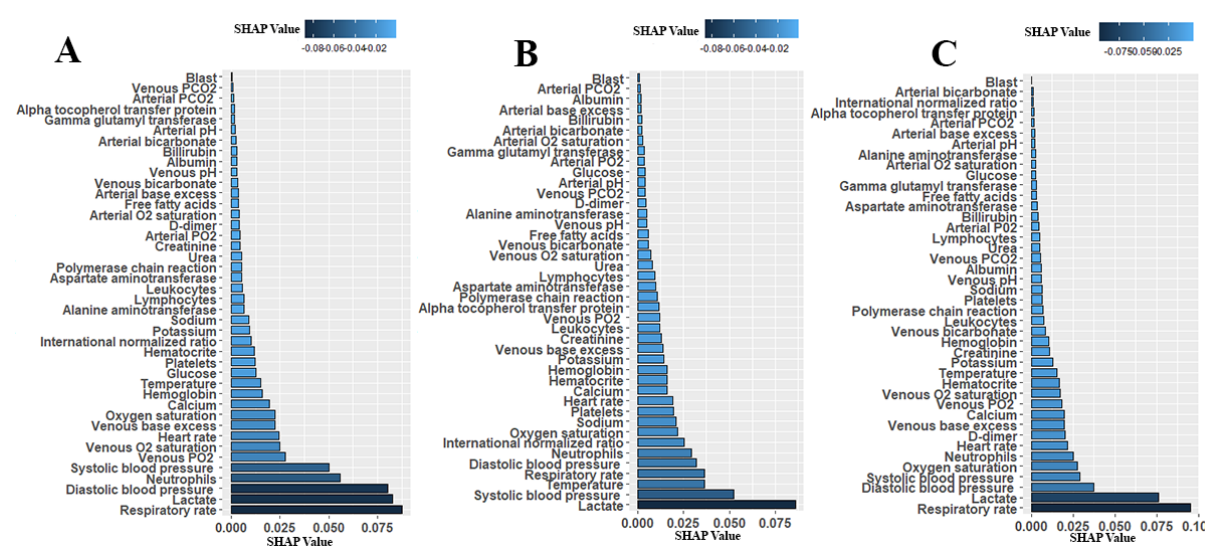
Figure 6. Sorted significant and impacted blood parameters of patients with COVID-19 based on SHAP values, defined as the coefficient values of each parameter after model training: (A) combined patients group; (B) patients with noncommunicable diseases; (C) patients without noncommunicable diseases. Artificial intelligence models were used to identify the most predictive blood parameters for the severity of COVID-19 symptoms. Higher coefficient values of machine learning model outcomes indicate a higher significant association with disease severity. D-dimer: dimerized plasmin fragment D; FFA: free fatty acids; GGT: gamma-glutamyl transferase; INR: international normalized ratio; SHAP: Shapley Additive Explanations; TTPA: partial thromboplastin